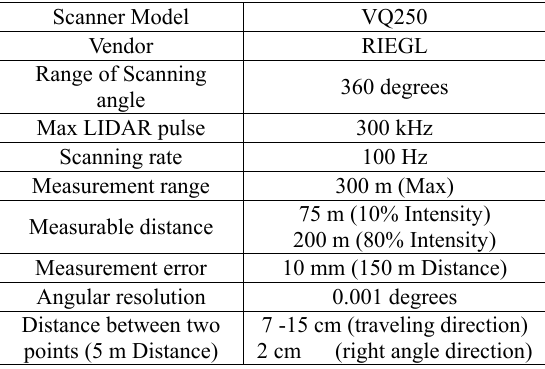
Table 3 . Specification of the LiDAR scanner